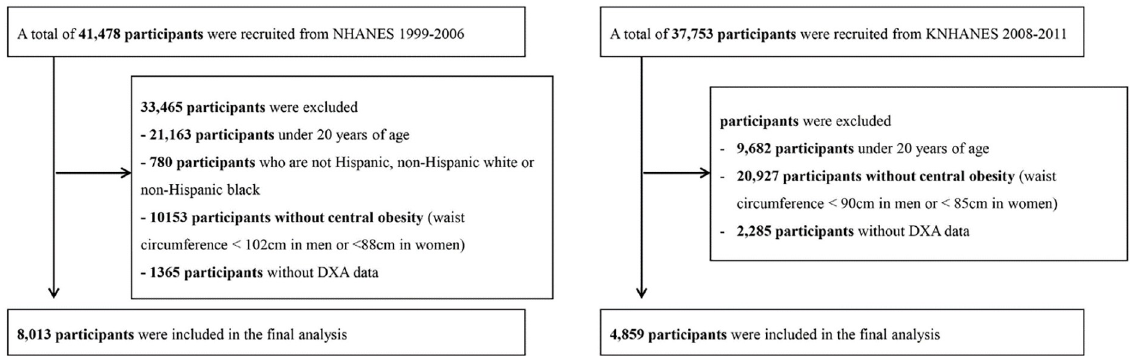
Fig 1. Flow chart of the final sample selection. NHANES, National Health and Nutrition Examination Survey.